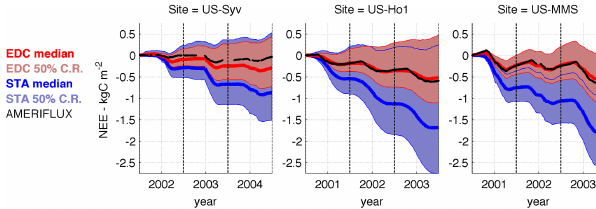
Figure 5. Three-year mean DALEC2 cumulative NEE (kgCm − 2 ) compared against cumulative measured NEE at three AmeriFlux sites: Sylvania Wilderness (US-Syv, mixed forest, left), Howland Forest (US-Ho1, evergreen needleleaf, middle) and Morgan Mon- roe State Forest (US-MMS, deciduous broadleaf, right). The stan- dard analysis median and 50% confidence ranges (CR) are shown in blue, and the corresponding analyses with EDCs are shown in red. AmeriFlux NEE measurements are denoted as a black line. The DALEC2 analyses – based on MODIS LAI retrievals, HWSD soil organic carbon estimates and ERA interim meteorological drivers – are completely independent of all AmeriFlux site